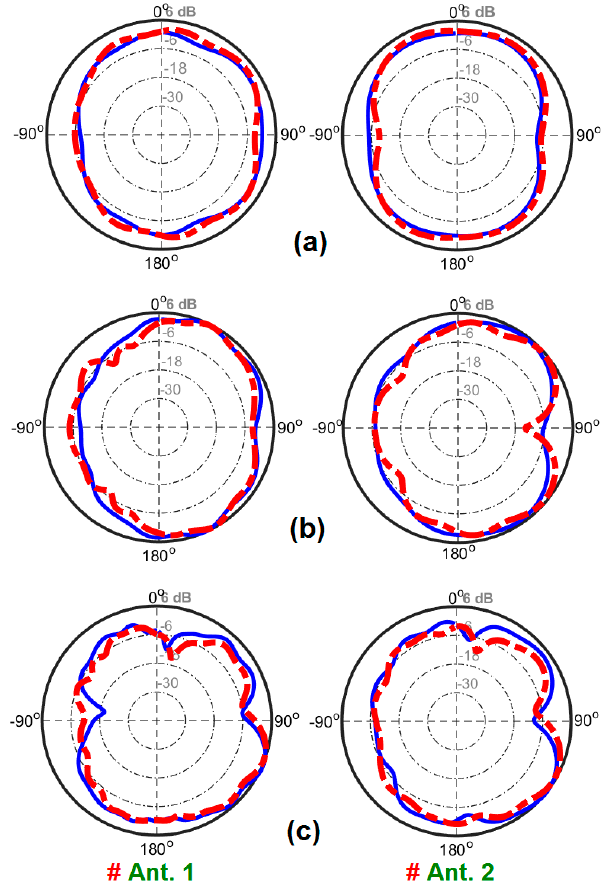
Figure 22. Measured (dash line ) and simulated (solid line) radiation pattern results for Ant. 1 and Ant. 2 at ( a ) 3 GHz, ( b ) 6 GHz, and ( c ) 9 GHz.